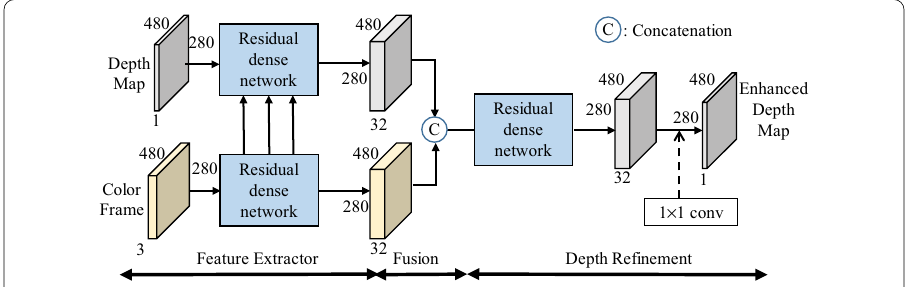
Fig. 5 The architecture of the proposed IGDE